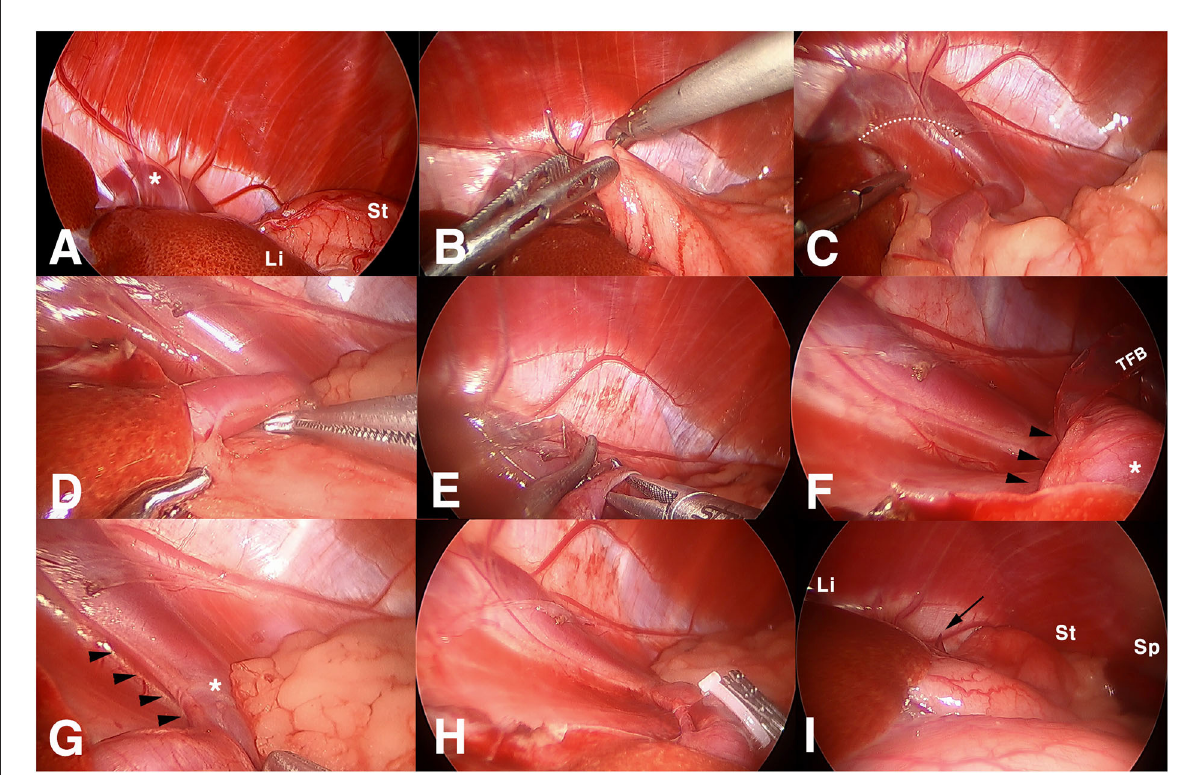
FIGURE3 Surgical images of laparoscopic attenuation of canine splenophrenic shunt using thin-film banding. (A) Laparoscopic view of diaphragm in left upper abdomen, (B) a suture being placed to the stomach for marionette retraction, (C) a shunting vessel entering the diaphragm, (D) dissecting shunting vessel from surrounding fat, (E) thin film band being passed through a perivascular window, (F) an arterial vessel identified inside the loop of thin film banding, (G) phrenic artery running alongside the shunting vessel, (H) completed thin film banding after additional intervascular dissection, and (I) final view after intraabdominal organs restored their position. Asterisk, shunting vessel; Li, liver; St, stomach; dotted line, incised line of the triangular ligament; TFB, thin-film band; arrowheads, arterial branch heading to the diaphragm; black arrow, the tip of the TFB; Sp,